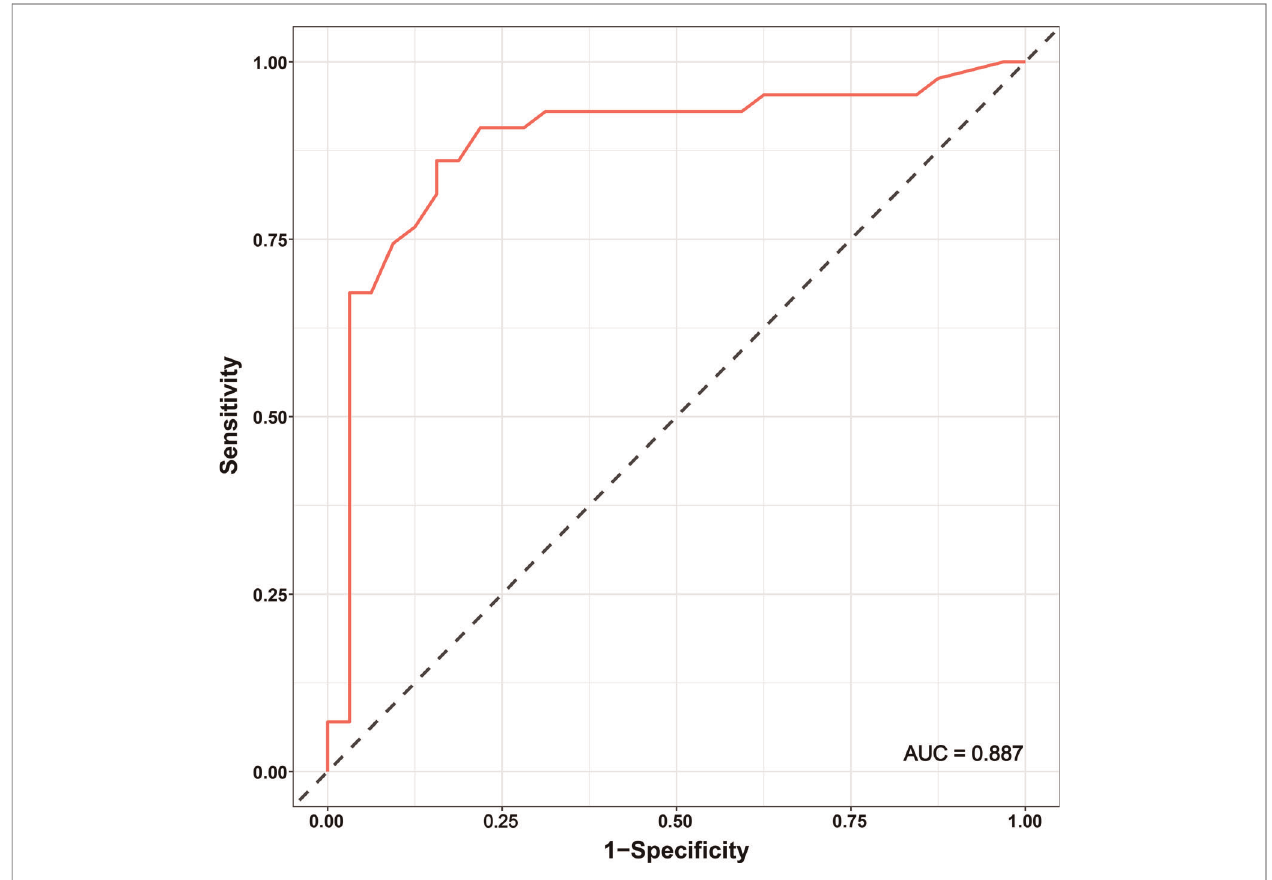
FIGURE 3 | ROC curve for completion of the learning